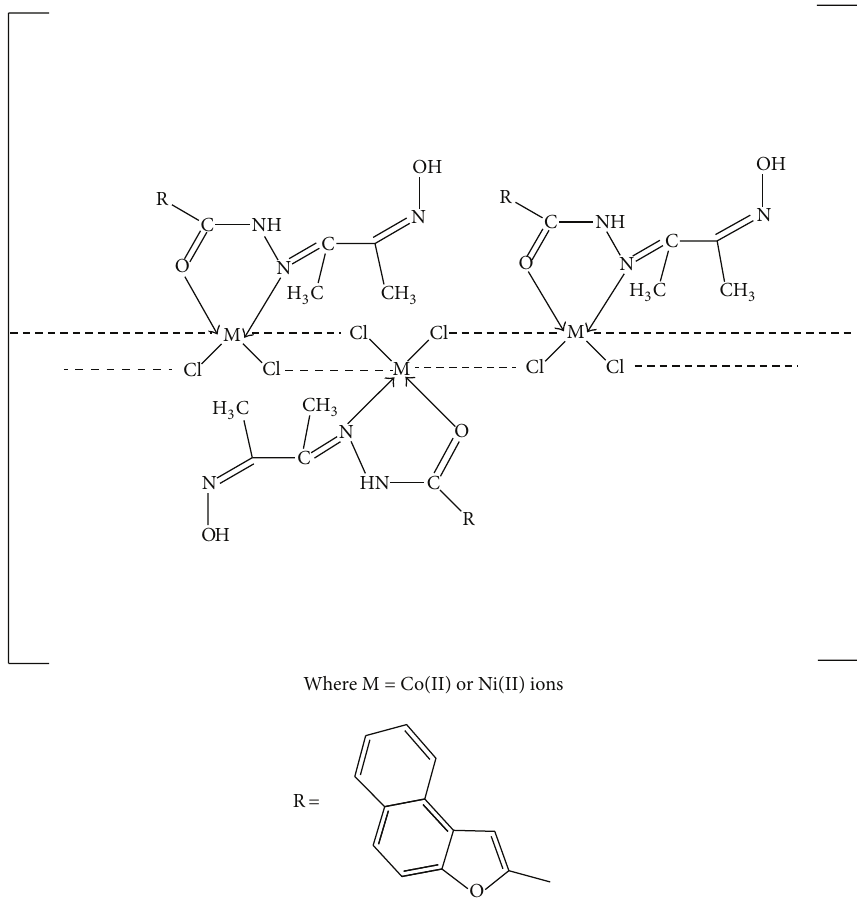
Figure 4: Suggested structure for [Co(C 17 H 15 O 3 N 3 )Cl 2 ]